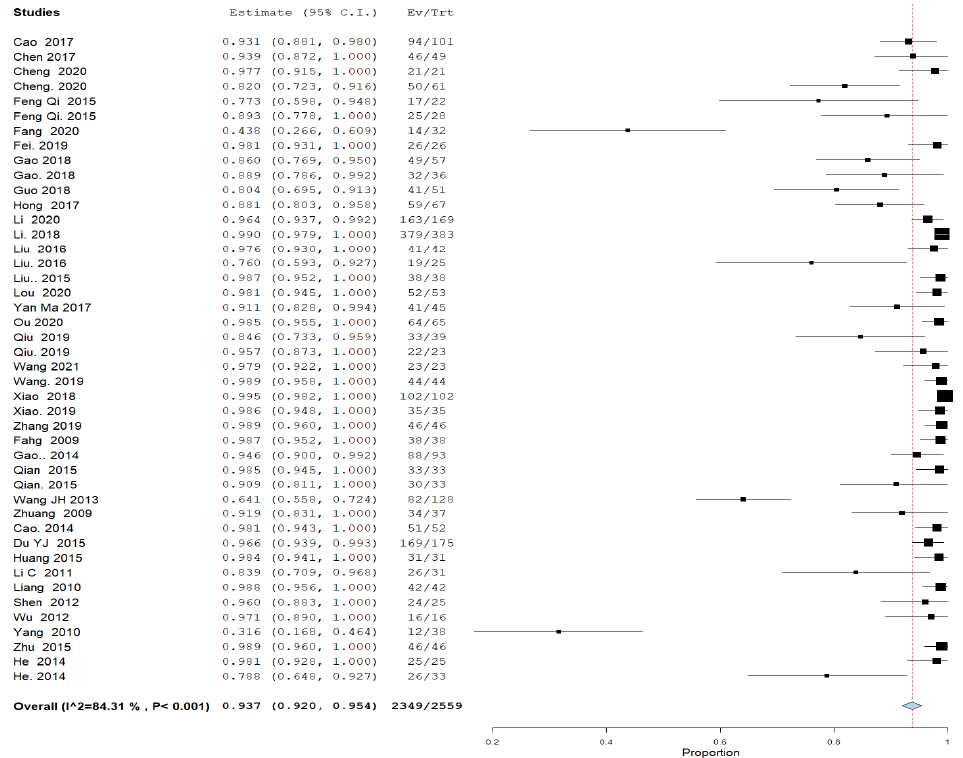
Figure 4. A forest plot of UAE success rate.